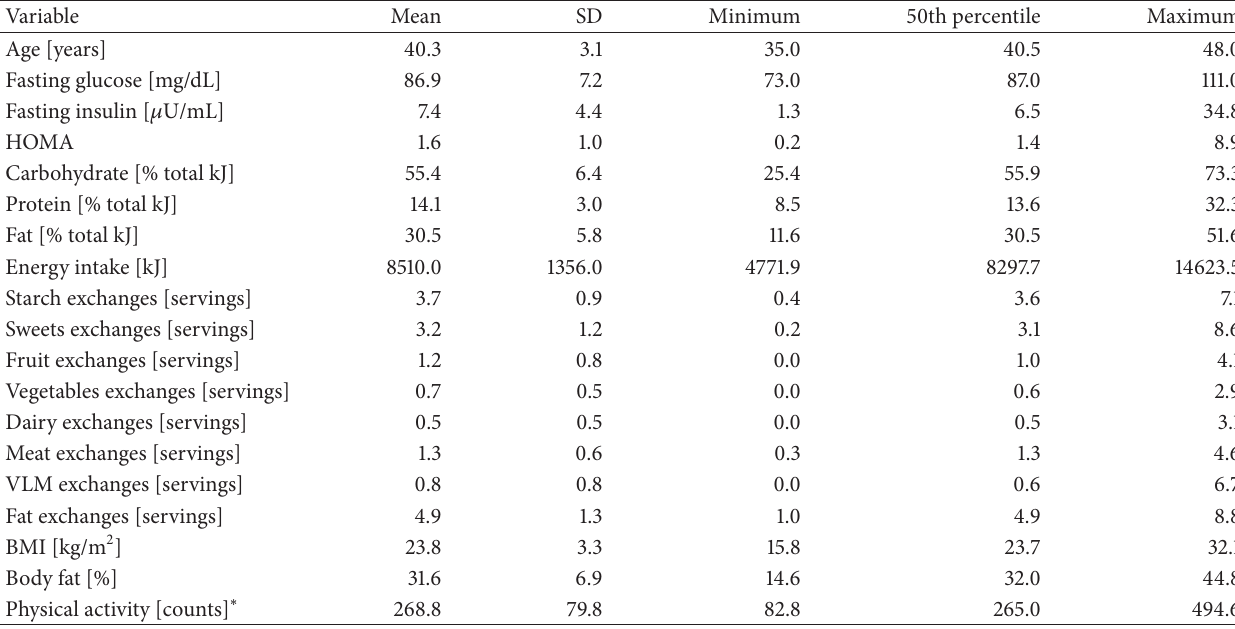
Table 1: Descriptive information about all participants [ 𝑛 = 292